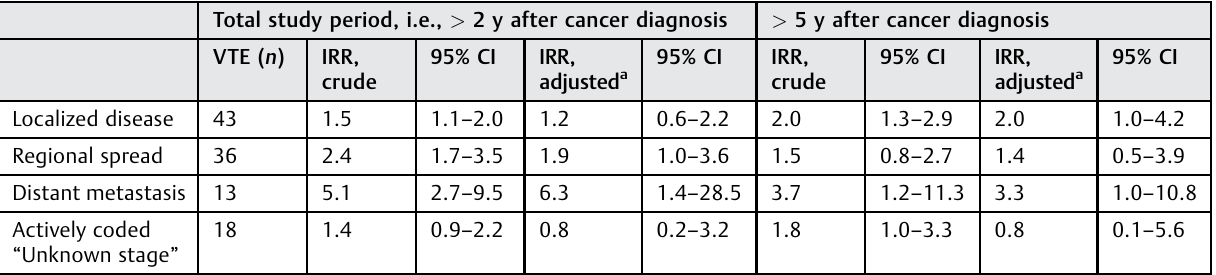
Table 4 Crude and adjusted IRRs of VTE strati fi ed on initial cancer stage in cancer-exposed subjects compared with their controls by increasing time since cancer